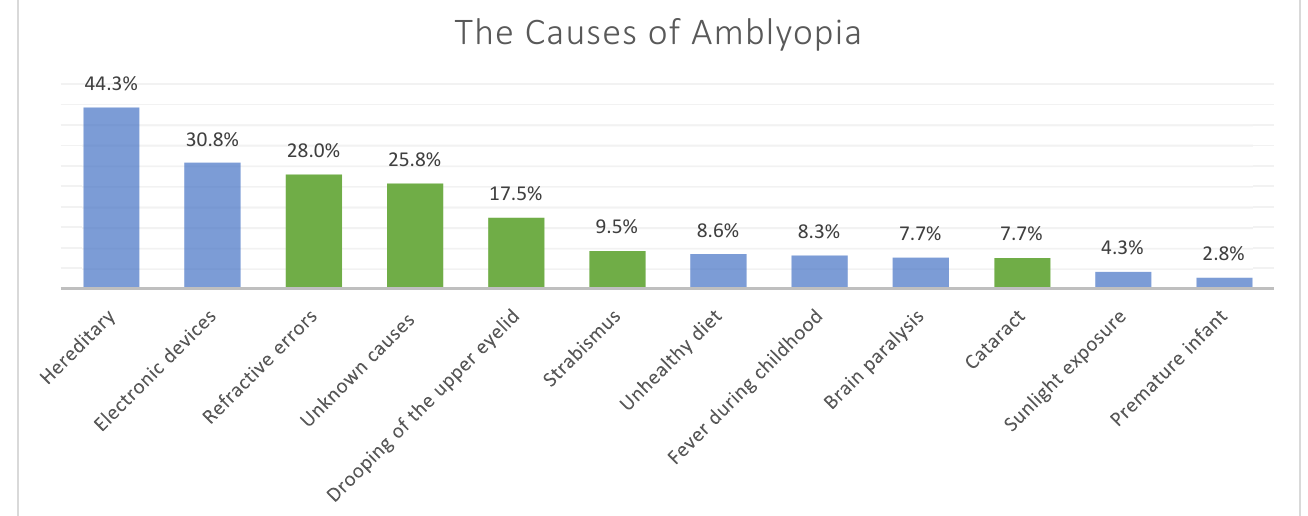
Figure 1. The proportions of participants’ responses for their knowledge regarding the definition of amblyopia, where they had the option to choose more than one answer. (The correct answers are represented by green bars and the incorrect answers by blue bars).